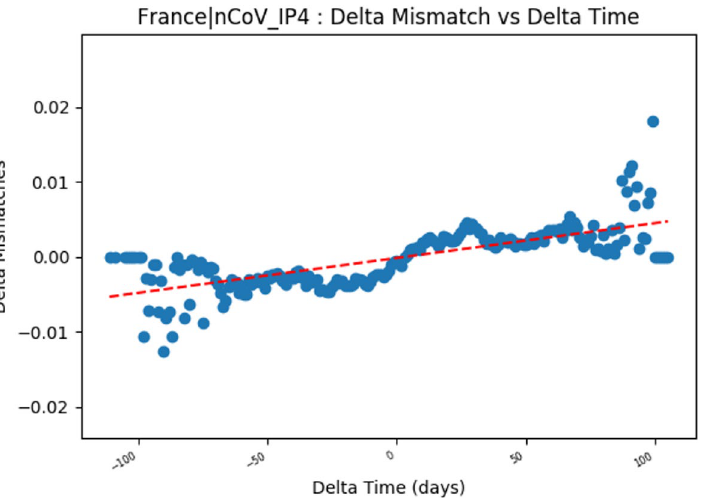
Figure 4. Change in number of mismatches between two occurrences over delta time between the two occurrences for the IP4 primer developed in France. The increasing slope shows that mutations are being sustained as we compare genomes that occur further apart in time. Graphs for all primers are included in the supplement.